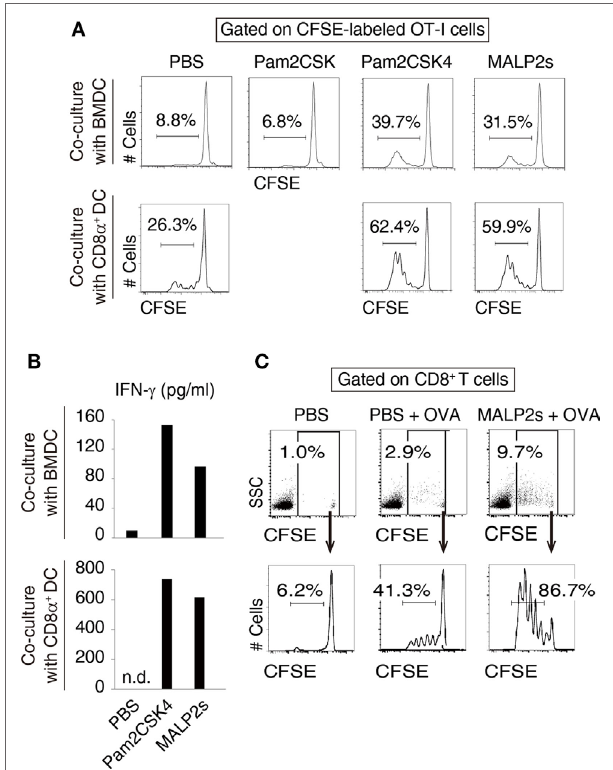
FigUre 1 | MALP2s induces cross-presentation in dendritic cells (DCs). (a,B) Bone marrow-derived dendritic cells (BMDCs) or CD8 α + DCs was stimulated with Pam2CSK4 or MALP2s in the presence of ovalbumin (OVA) and cocultured with carboxyfluorescein diacetate succinimidyl ester (CFSE)- labeled OT-I cells. PBS and Pam2CSK were negative controls. (a) The percentage of dividing cells among CFSE-labeled OT-I cells was analyzed by flow cytometry. The upper and lower panels show the result of coculture with BMDCs and CD8 α + DCs, respectively. (B) The concentrations of INF- γ in the culture medium were measured by ELISA. The upper and lower graphs show the results of coculture with BMDCs and CD8 α + DCs, respectively. n.d.: not detected. (c) CFSE-labeled OT-I cells-transferred WT mice were administered with PBS, OVA, or MALP2s + OVA. The percentage of CFSE-labeled OT-I cells among splenic CD8 + T cells (upper panels) and the percentage of dividing cells among CFSE-labeled OT-I cells (lower panels) were analyzed by flow cytometry. n = 1 per group. [ (a) lower graph of (B) and (c) ] The results are representative of more than two independent